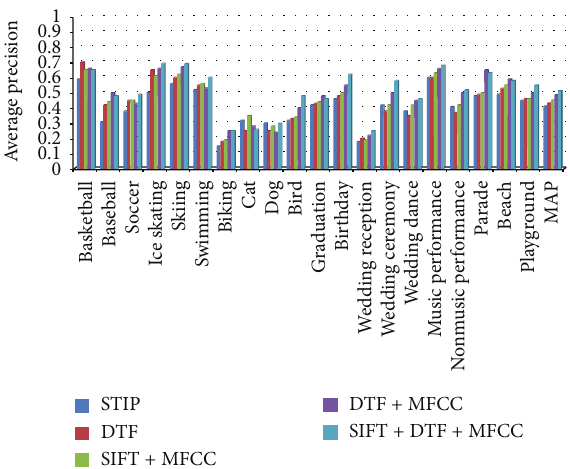
Figure 3: Performance of low-level features on CCV